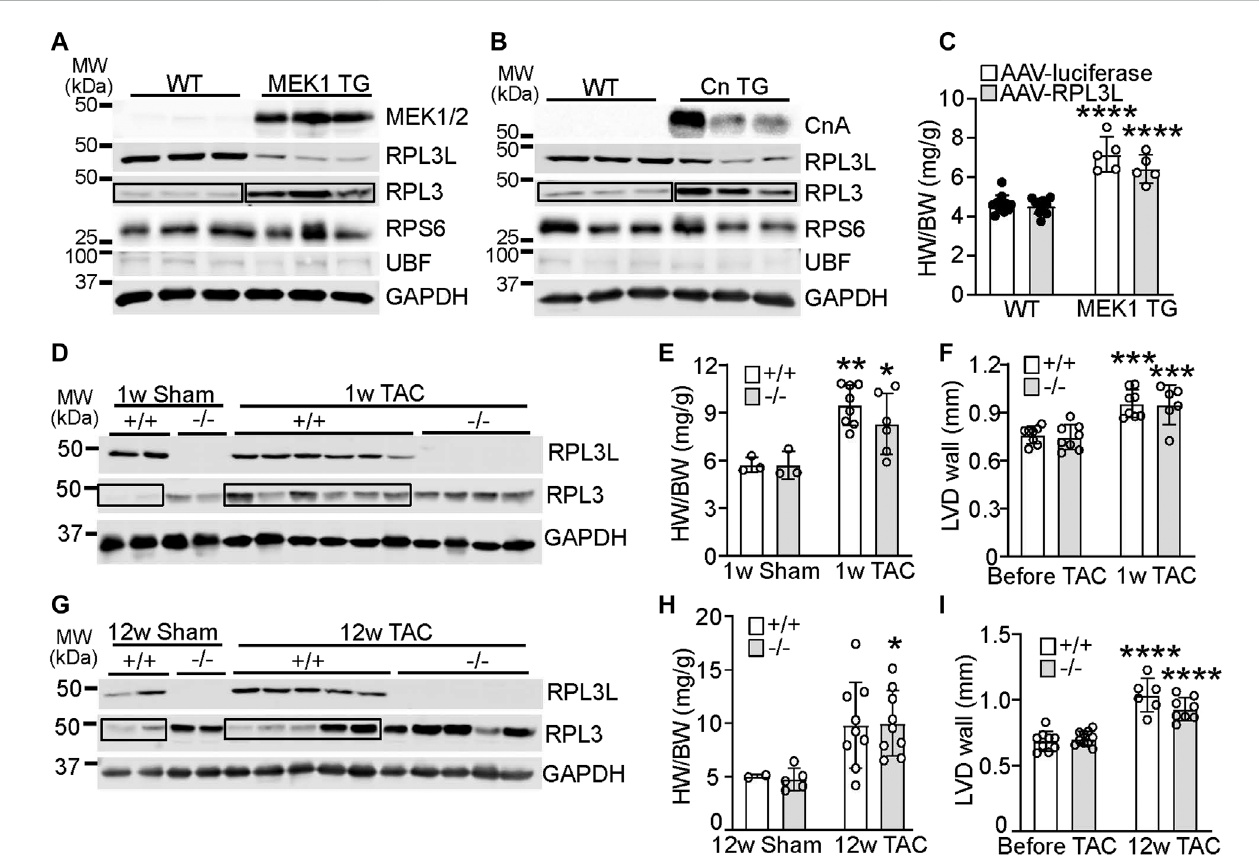
boxed area shows the upregulation of RPL3 protein in the TG hearts versus the control. (B) Western blots showing expression of the indicated proteins in hearts from transgenic mice expressing activated calcineurin (CnTG) compared to wild type littermates ( n = 3). CnA represents the migration of the activated form of the calcineurin A protein from the Cn transgene, which is shorter than the endogenous form of calcineurin. The boxed area shows the upregulation of RPL3 protein in the TG hearts versus control. (C) Heart weight to body weight ratios in 3-month-old MEK1 transgenic and wild type mice previouslyinjectedwithAAV-luciferaseorAAV-RPL3L( n =5 – 11,****= p < 0.0001comparedtorespectivewildtypecontrols,bySidak ’ smultiplecomparisons testafter 2-way ANOVA). (D) Westernblotting for RPL3 and RPL3L expression inwildtypeand Rpl3l − / − heartsafter TACor ashamsurgicalprocedure begun at 2 months of age and followed for 1 week before harvest. GAPDH is shown as a processing and loading control. ( n = 2 – 6/group). The boxed area shows the increase in RPL3 protein with TAC in the +/+ (WT) mouse hearts compared to respective sham. (E) HW/BW ratios of wild type and Rpl3l − / − mice after TAC or sham procedure for 1 week ( n = 3 – 8, ** = p < 0.01, * = p < 0.05 compared to respective sham controls, by Sidak ’ s multiple comparisons test after 2-way ANOVA). (F) Average left ventricular wall thickness by echocardiography in diastole (LVD wall) of wild type and Rpl3l − / − mice at baseline and 1 week after TAC surgery ( n = 6 – 8; *** = p < 0.001 compared to same mice before TAC, by Sidak ’ s multiple comparisons test after 2-way ANOVA). (G) Western blotting for RPL3 and RPL3L expression in wild type and Rpl3l − / − hearts after TAC compared to a sham surgical procedure begun at 2 months of age and followed for 12 weeks before harvest ( n = 2 – 5/group). GAPDH is shown as a processing and loading control. The boxed areas show the changes in RPL3 protein with TAC in the +/+ (WT) mouse hearts compared to sham. (H) HW/BW ratios of wild type and Rpl3l − / − after TAC or sham procedure for 12 weeks ( n = 2 – 9, * = p < 0.05 compared to respective sham controls, by Sidak ’ s multiple comparisons test after 2-way ANOVA). (I) Average left ventricular wall thickness in diastole (LVD wall) of mice at baseline and 12 weeks after TAC surgery ( n = 6 – 12; **** = p < 0.0001 compared to same mice before TAC, by Sidak ’ s multiple comparisons test after 2-way ANOVA). Data are mean ±